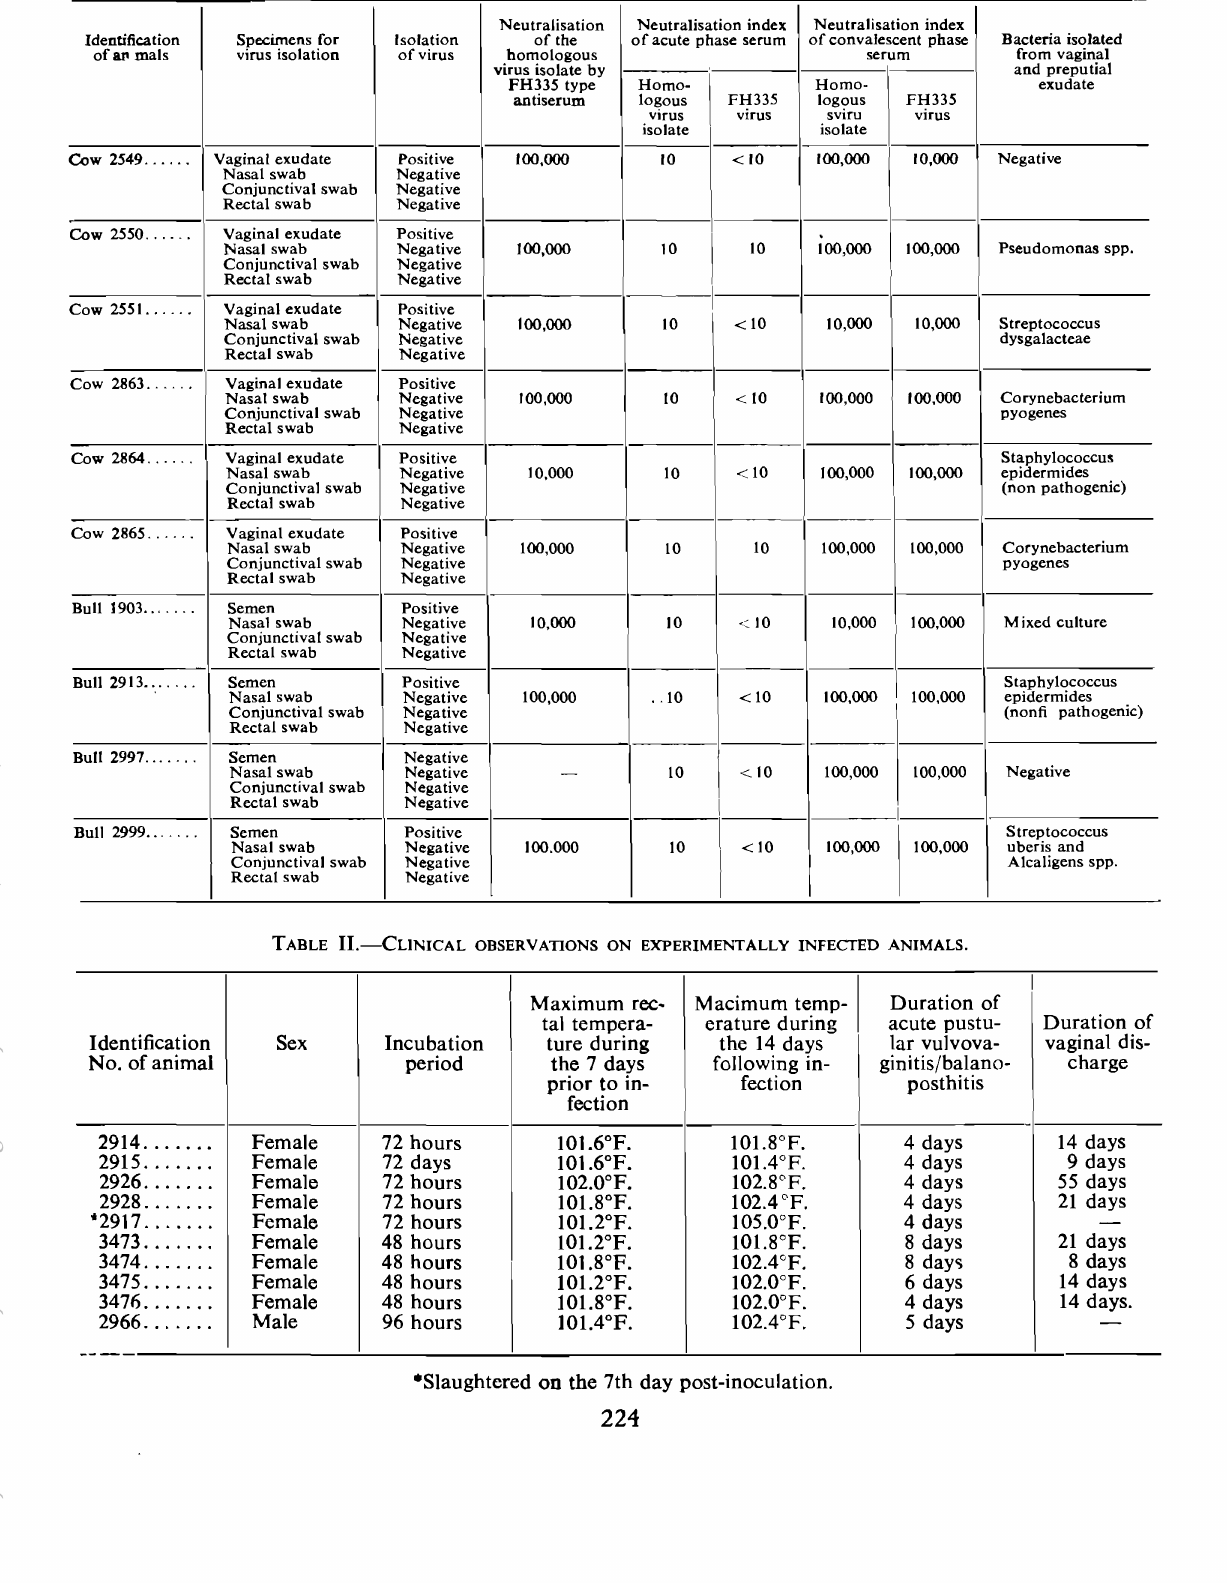
TABLE n.-CLINICAL OBSERVATIONS ON EXPERIMENTALLY INFECTED